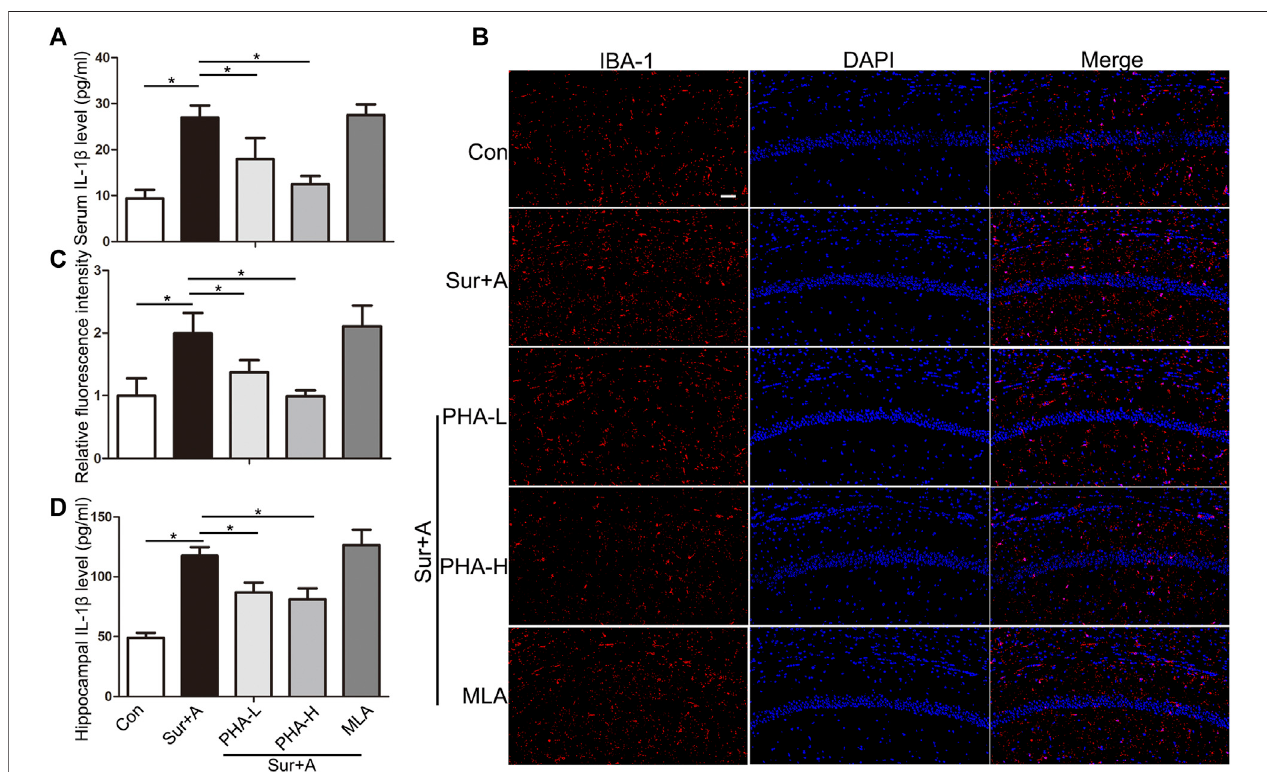
FIGURE 3 | Effects of α 7nAChR stimulation on systemic and hippocampal in fl ammatory response in aged mice. (A) Levels of IL1 β in the serum 24 h after surgery. (B) Representative images of IBA-1 positive microglia (red) in the hippocampi of CA1 region. (C) Quanti fi cations of the relative fl uorescent intensity for IBA-1 positive microglia in hippocampal CA1 region. (D) Levels of IL1 β in the hippocampus 24 h after surgery. Data are presented as mean ± SD. DAPI staining is shown in blue. * p < 0.05. Scale bar = 50 μ m. Con, Control; Sur+A, Surgery plus Anesthesia; PHA-L, low-dose PHA (0.3 mg/kg); PHA-H, high dose PHA (0.6